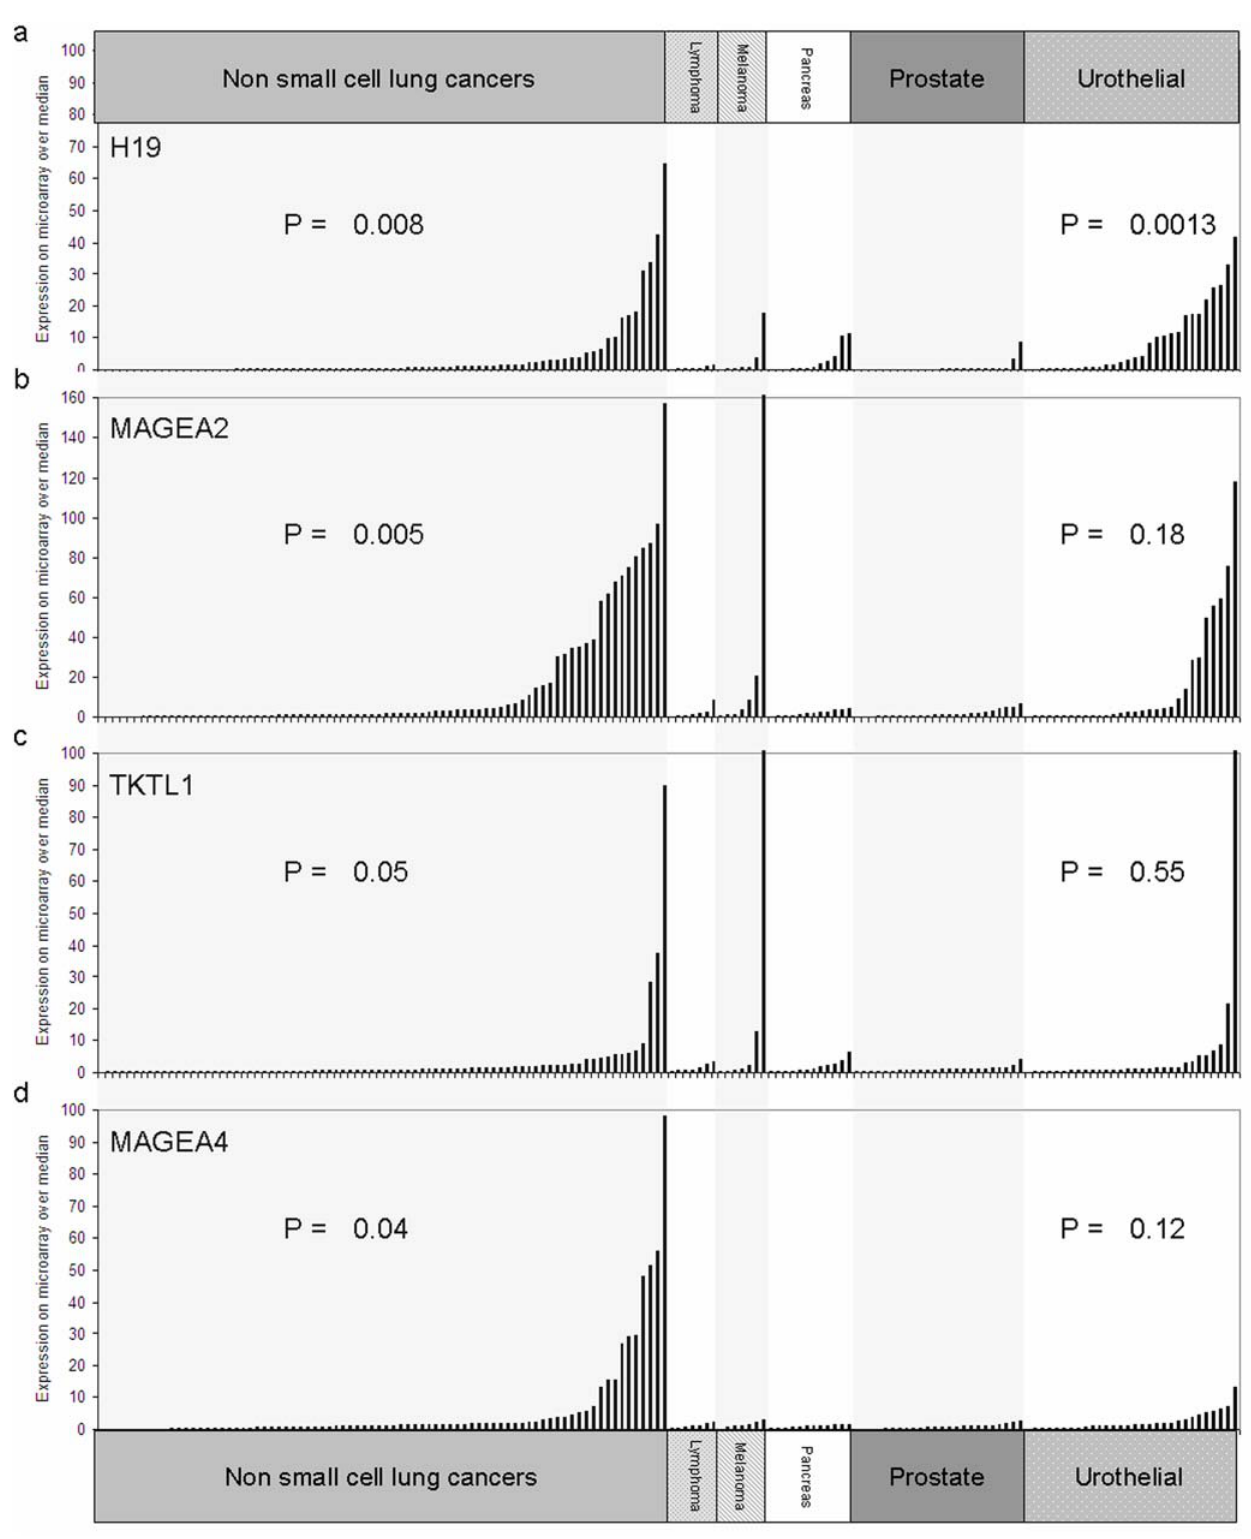
Figure 5. Overexpression and demethylation in other human cancers. The expO dataset repository was mined for tumor tissue gene expression measured by the Affymetrix U133 Plus 2.0 mRNA expression platform. Initially data was median-normalized by expression array and each gene was median normalized for this figure. Only the subsets of non small cell lung cancer, lymphoma, melanoma, pancreas cancer, and urothelial cancer are displayed. ( a ) shows the expression of H19 in these cancers. ( b ) MAGEA2 expression, ( c ) TKTL1 expression, and ( d ) MAGEA4 . Statistical significance was measured in each tumor type by comparing gene expression in the tumor type to expression in all the remaining 1041 samples. Tumor types without p values did not approach statistical significance. Lung and urothelial showed significant expression overlap. doi:10.1371/journal.pone.0004961.g005 PLoS ONE |